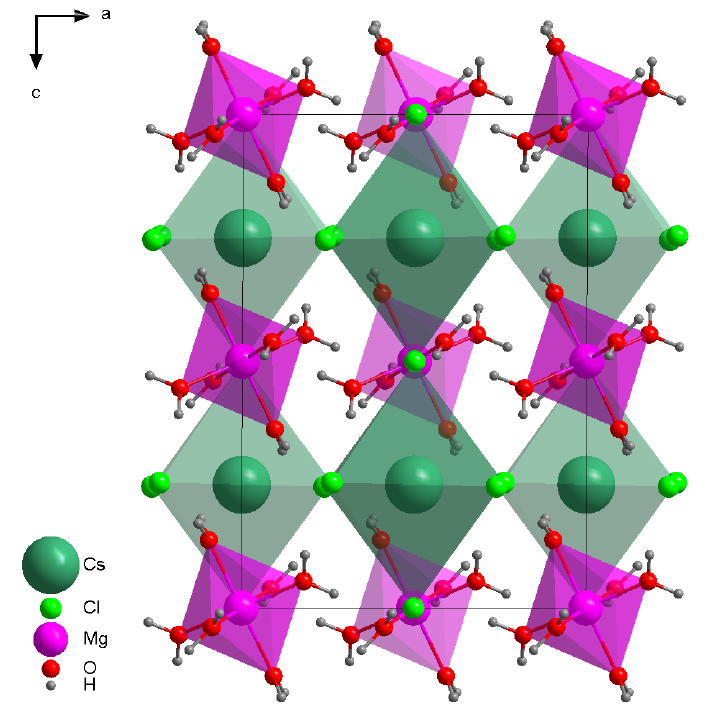
· CsCl · 6H O double salt, ac projection. 2 2